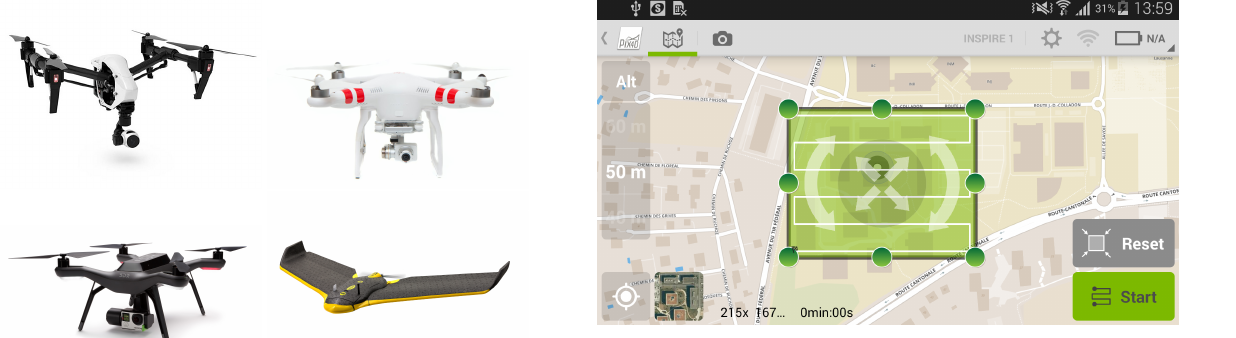
Figure 3: Mission planning in Pix4Dcapture, depicted here for the Inspire 1. The App controls taking the pictures, yielding very similar datasets for the different drones. The drone will follow the path represented by the white line in the green selection